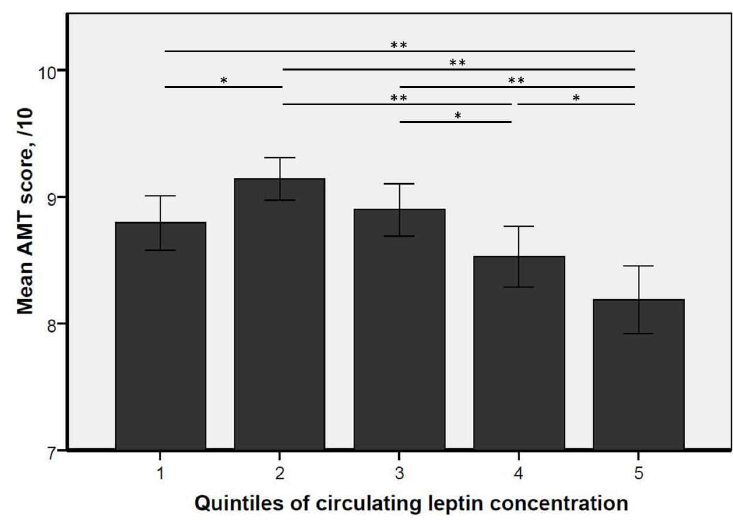
Figure 2. Bar plots for mean and standard deviation of Abbreviated Mental Test score according to the quintiles of circulating leptin concentration ( n = 1061; overall p -value < 0.001). *: p < 0.05; **: p < 0.001.